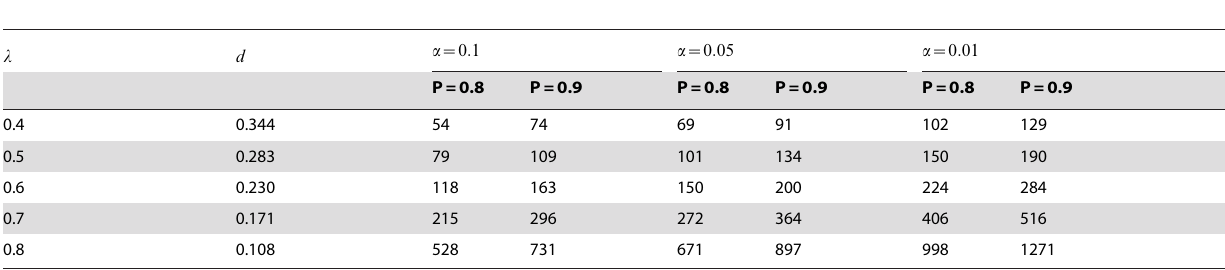
Table 3. Sample size estimation to detect at least l ~ 0 : 4 , 0.5, 0.6, 0.7 and 0.8 truly altered regions for the desired power up to 0.8 and 0.9, with different significance